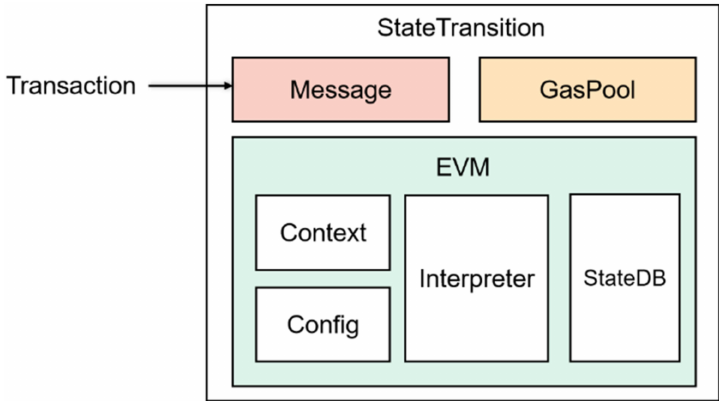
Figure 1. EVM business